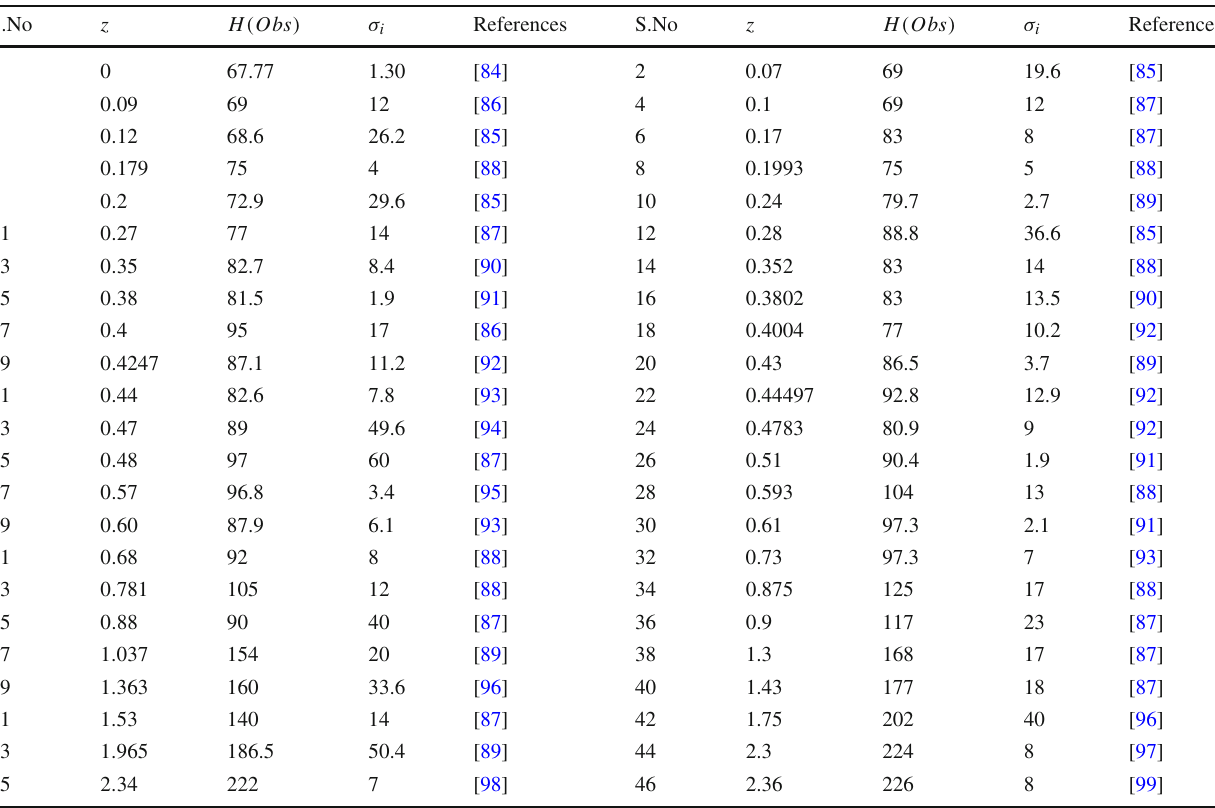
Table 1 The behavior of Hubble parameter H against redshift parameter z [83]